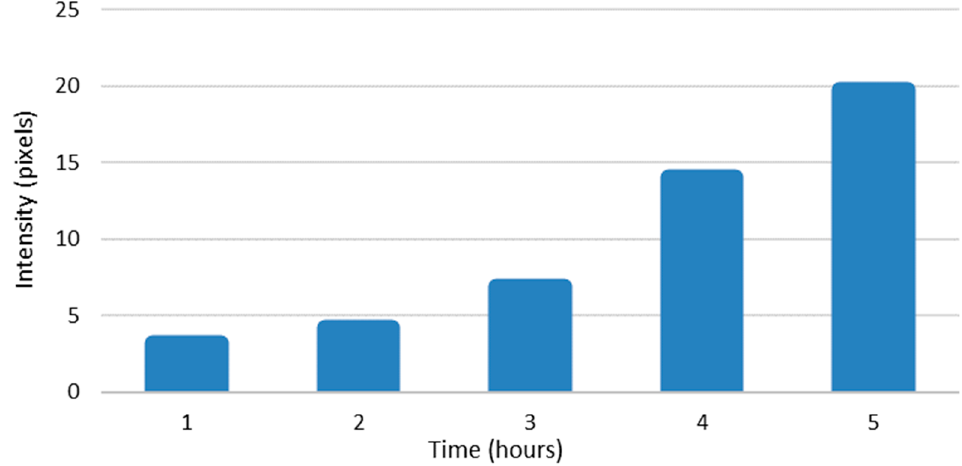
Figure 6. The amount of viral − RNA in CVA9-infected cells at timepoints 0–5 h p.i., as calculated from bDNA FISH image intensity values. The bars represent pixels that have intensity values above the background threshold, calculated from ≈ 100 cells.